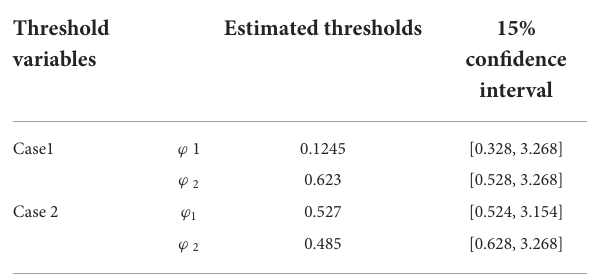
TABLE 7 Threshold